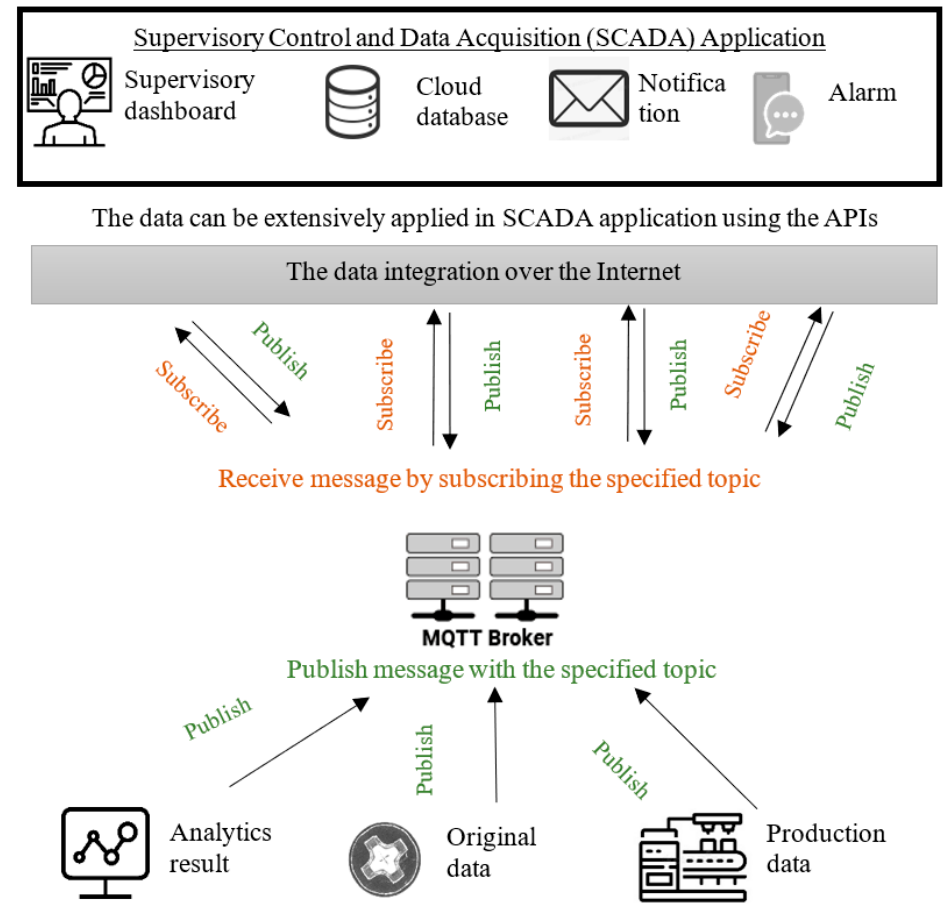
Figure 9. Real-time SCADA using MQTT protocol.